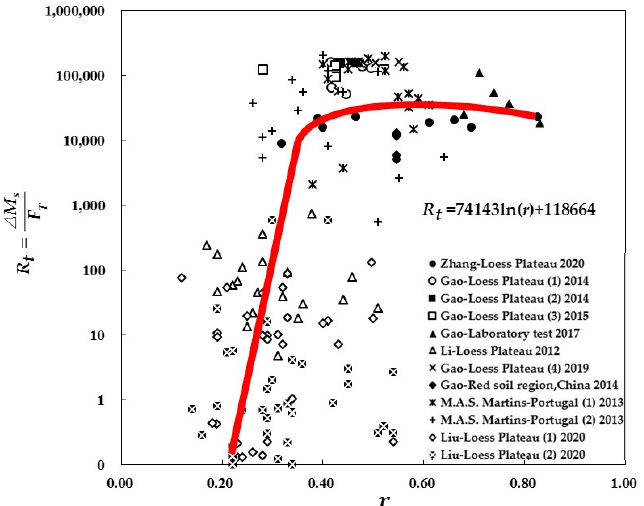
Figure 8. Relationship between the terrace-erosion-reduction benefit ( R t ) and space–distance ratio of terraces ( r ). Table 8. Information about different scholars.